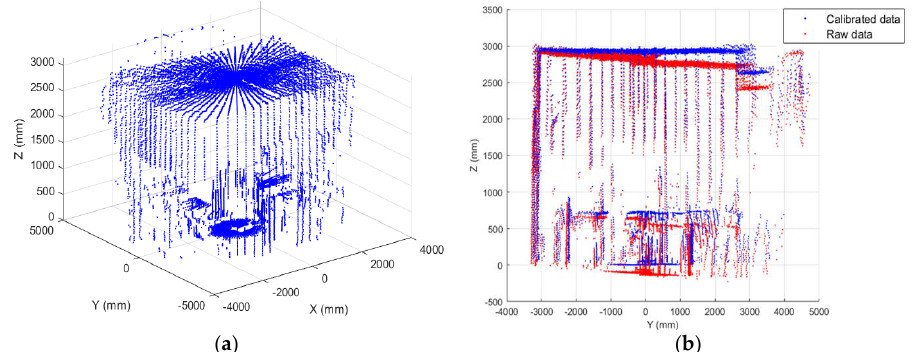
Figure 17. ( a ) 3D reconstruction scenario from calibrated data; ( b ) Comparison between raw and calibrated data (yz-plane).